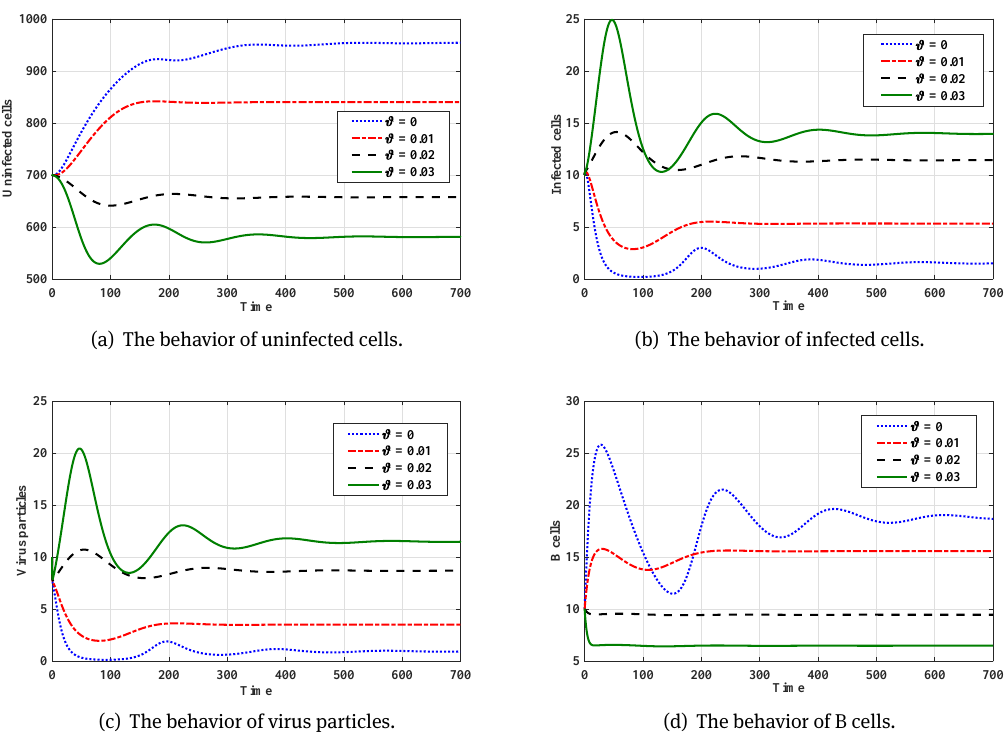
Figure 4: Solution trajectories of system (31)-(34) for different values of ϑ